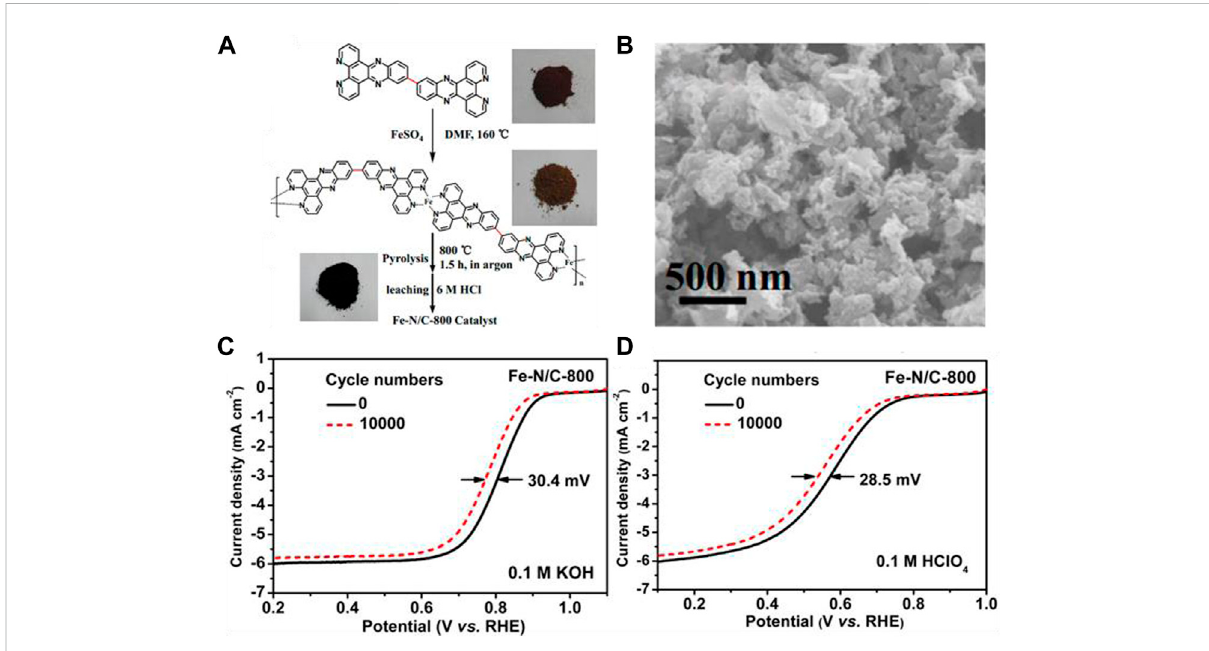
FIGURE 10 (A) Illustration of the synthetic process of the FeN/C-800 catalyst; (B) SEM image of the as-prepared catalyst; (C,D) Stability test of the as- prepared catalyst in